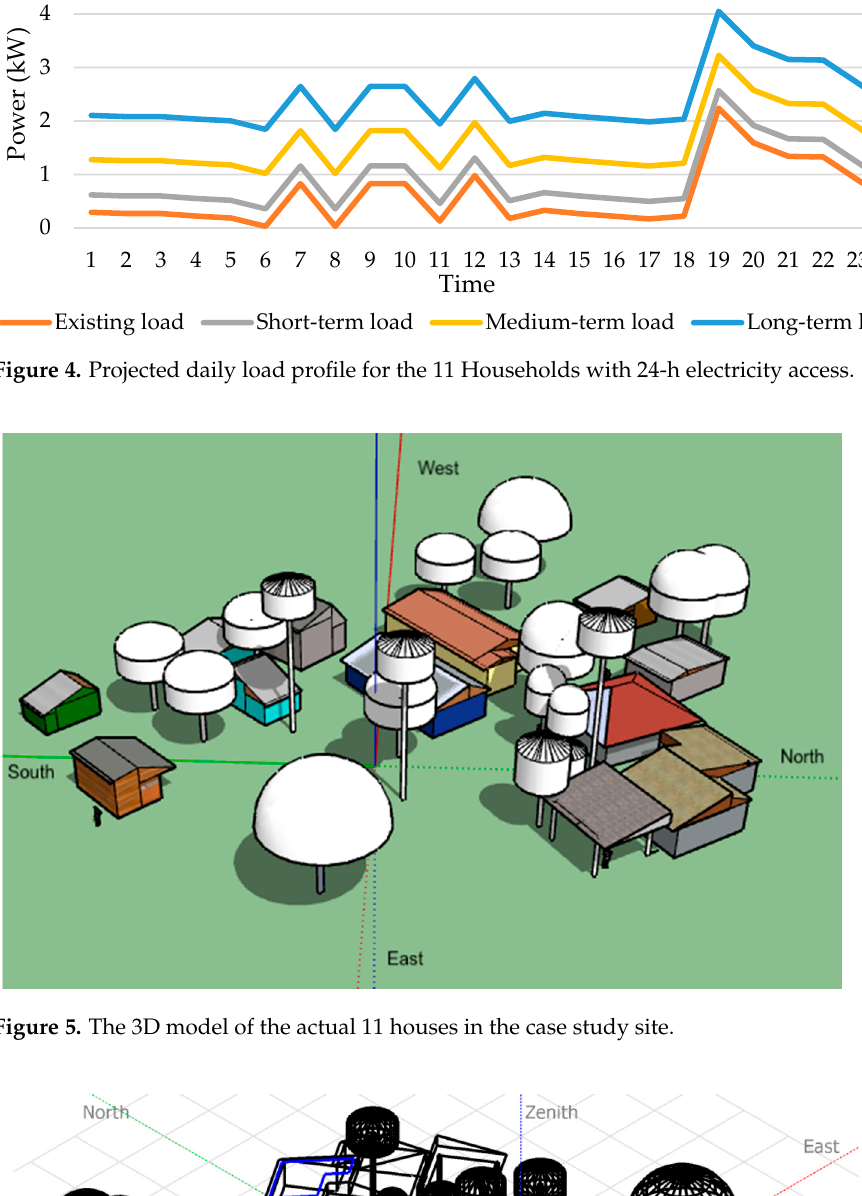
Figure 4. Projected daily load profile for the 11 Households with 24-hour electricity access.